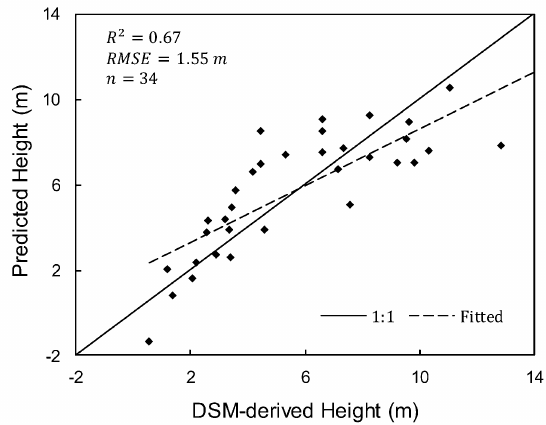
Figure 7. Comparison of the model-predicted heights and the DSM-derived heights for the training samples. Legend: R 2 , coefficient of determination; RMSE, root mean square error.